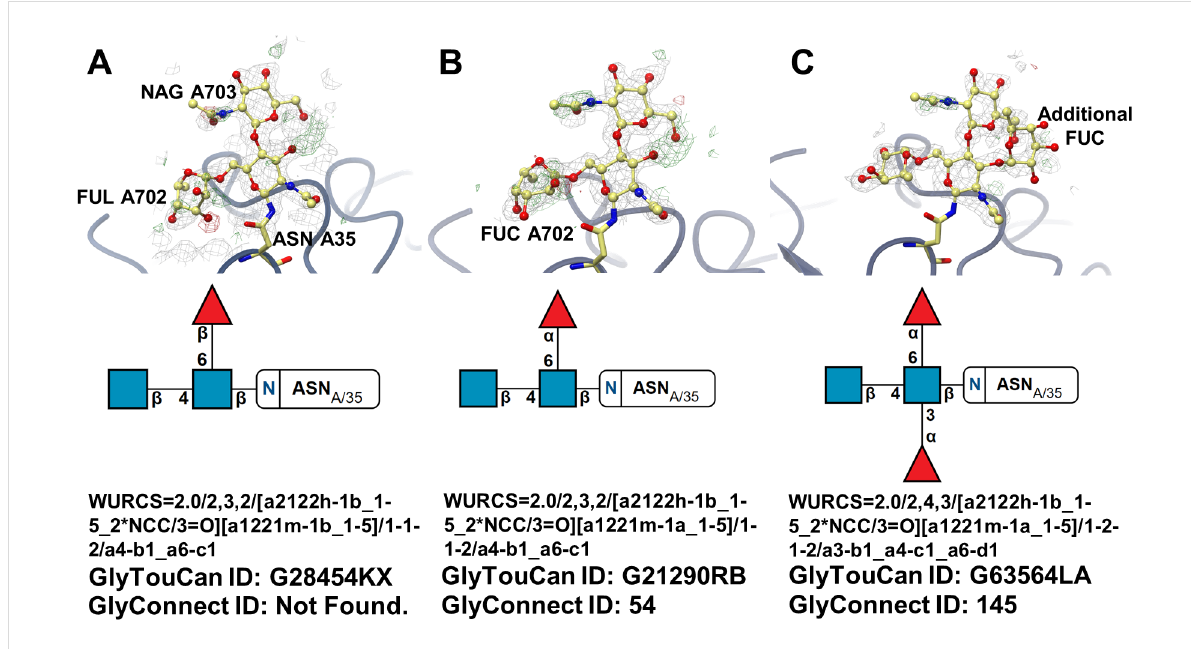
Figure 4: An N -linked glycan attached to Asn35 of human Toll-like receptor 4 (A: PDB entry 2z62 [68]). Model iteratively rebuilt by PDB-Redo as shown in steps B and C [41]. Pictures at the top depict glycoprotein models of the region of interest and electron-density maps of the glycan chain (grey: 2mFo DFc map, green and red: mFo DFc difference density map). Pictures at the bottom depict the SNFG representations of glycan chains, their WURCS sequence and accession IDs to relevant databases (taken directly from Privateer's CCP4i2